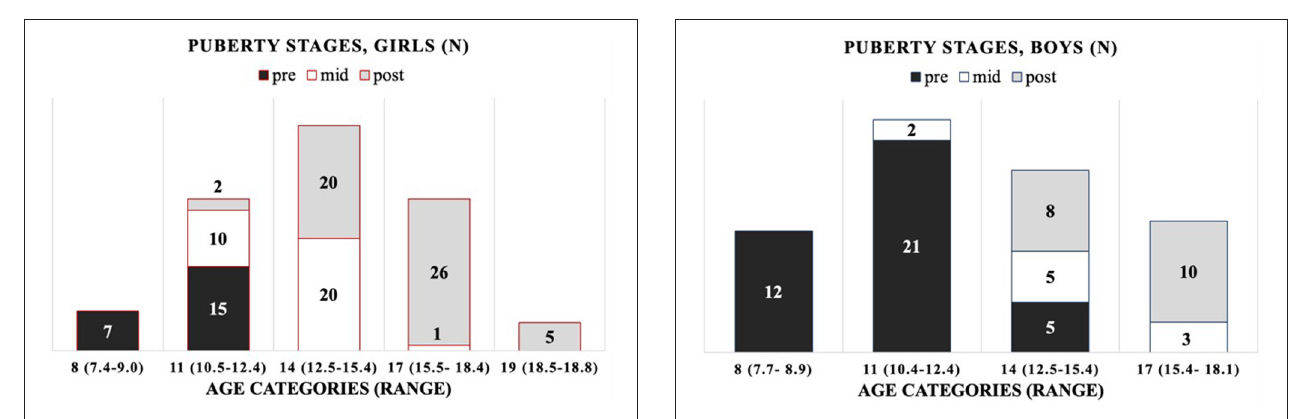
FIGURE 1 | Progression of puberty status per age category for girls ( n per puberty category).